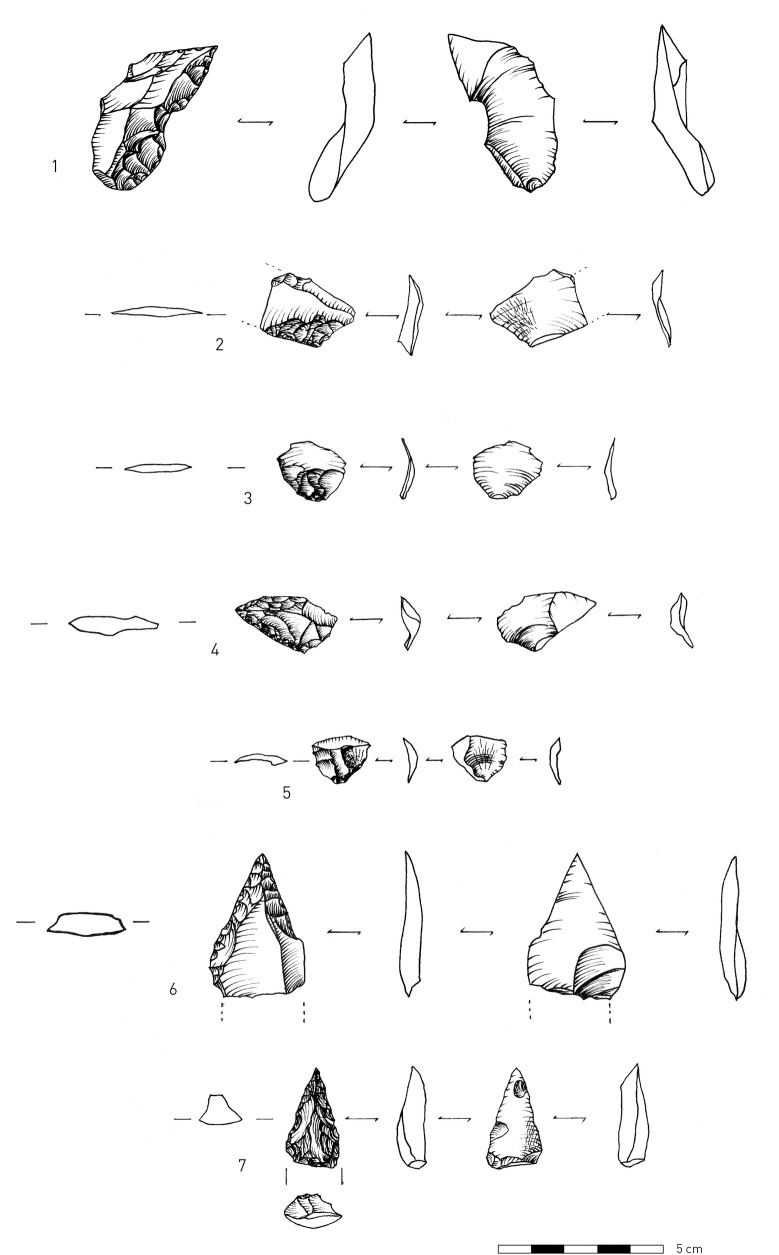
Obsidian lithic artifacts.1, 4–5. Shaping flakes that removed the tips of convergent retouched points; 2–3. Shaping flakes; 6–7. Retouched points. (Illustration: P. Glauberman).